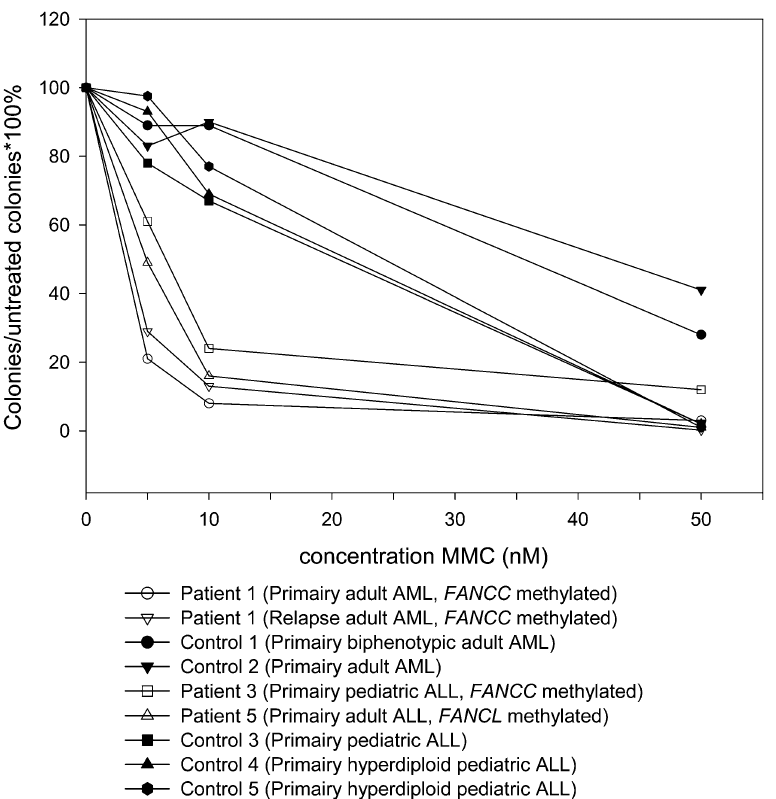
Fig. 3. Mitomycin C (MMC) sensitivity in Colony Forming Units (CFU) assay. Number of colonies scored following a 7-day culture in Methocult culture medium with increasing concentrations (5, 10 and 50 nM) of MMC, expressed as percentage of the number of scored colonies in the untreated (0 nM MMC) fraction. Open symbols, patients with FA-BRCA gene promoter methylation (patient 1, bifenotypic AML, FANCC methylated; patient 3, paediatric ALL, FANCC methylated; patient 5, adult ALL, FANCL methylated). Black symbols, controls (control 1, biphenotypic adult AML, control 2, primary adult AML, control 3, primary paediatric ALL, controls 4 and 5, primary hyperdiploid adult